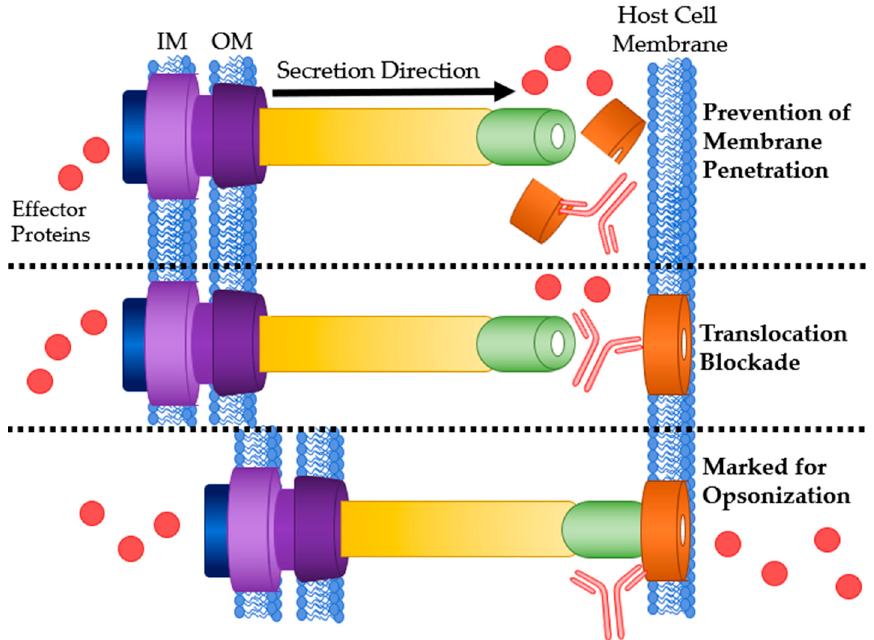
Figure 5. Mechanisms of Ab interaction with T3SS translocon proteins. Top : Ab binding to translocon proteins after secretion preventing host membrane penetration and pore formation. Middle : Physical blockage of translocation by Ab binding. Bottom : Ab bound to the translocon marking it for opsonization or ADCC. IM: bacterial inner membrane; OM: bacterial outer membrane.